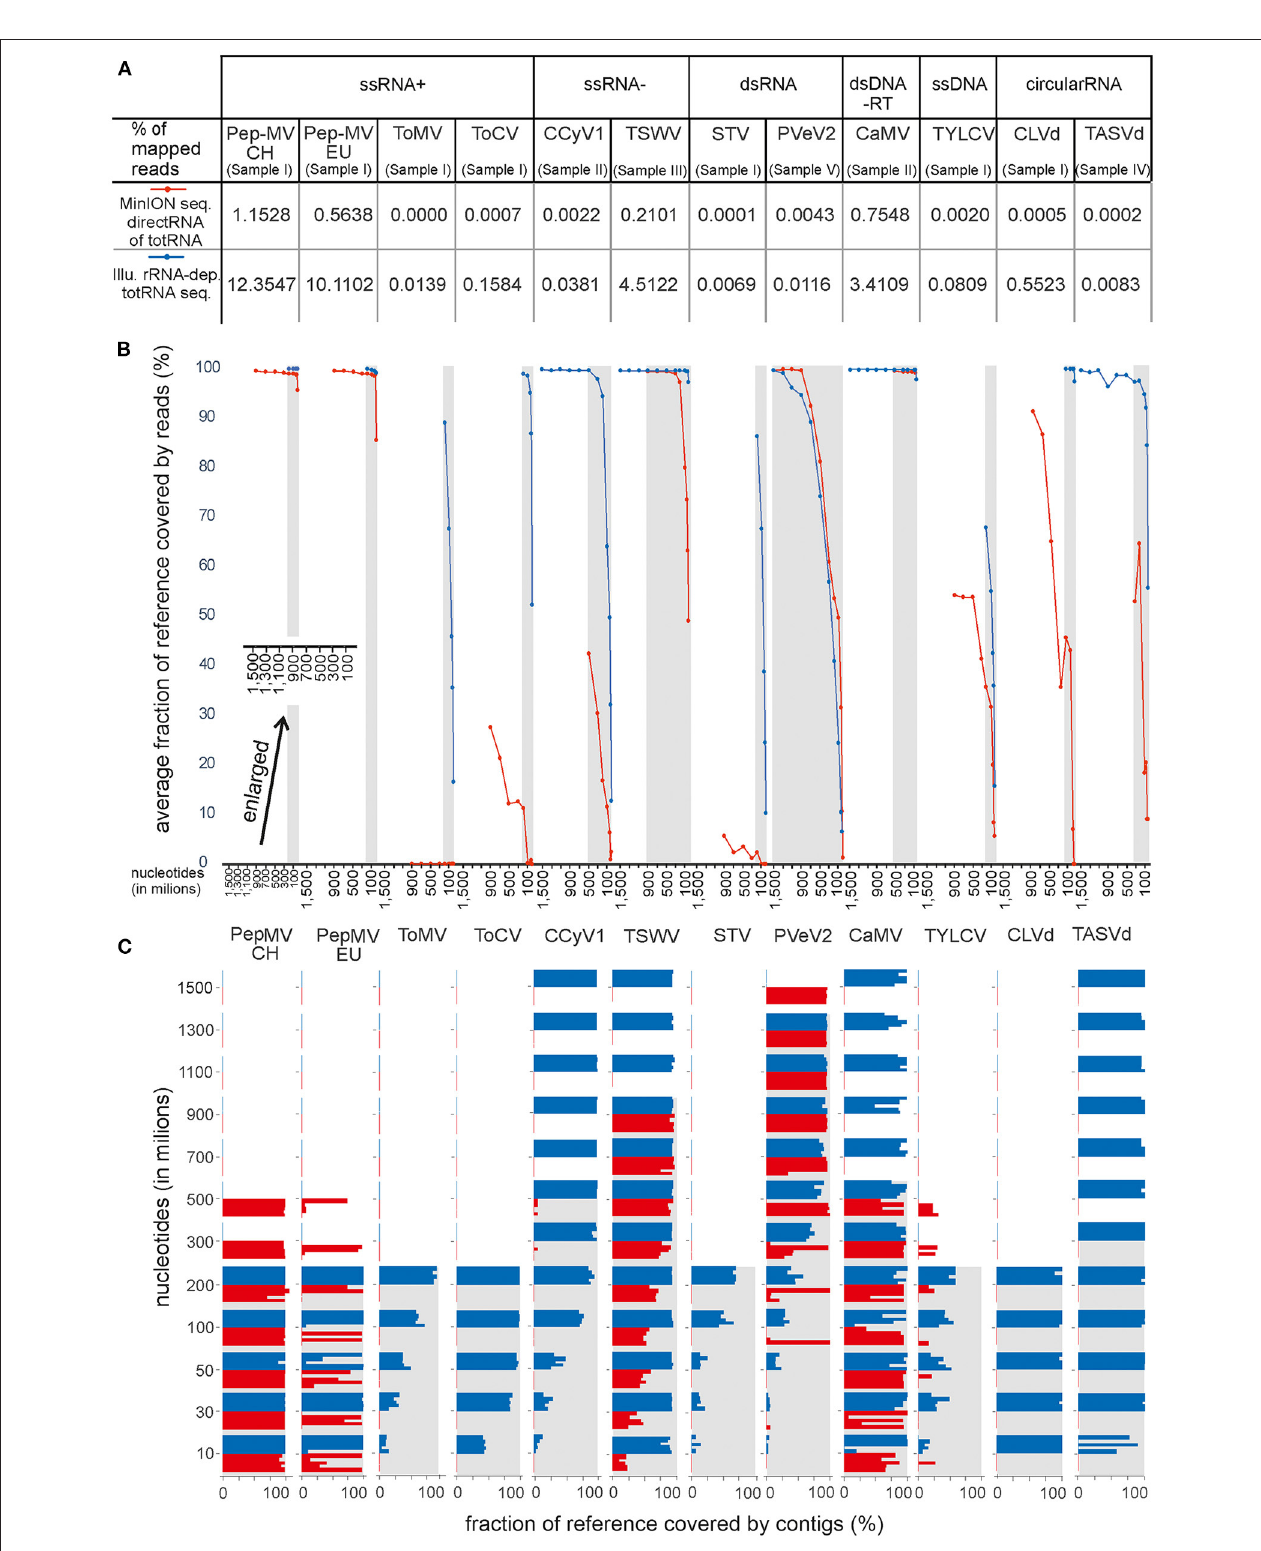
FIGURE 3 | Comparison of MinION direct RNA sequencing of totRNA (represented in red) and Illumina sequencing of rRNA-depleted totRNA (represented in blue) using data size-normalized subsamples. Results for each virus included in the analysis are shown along the x-axis and are grouped according to